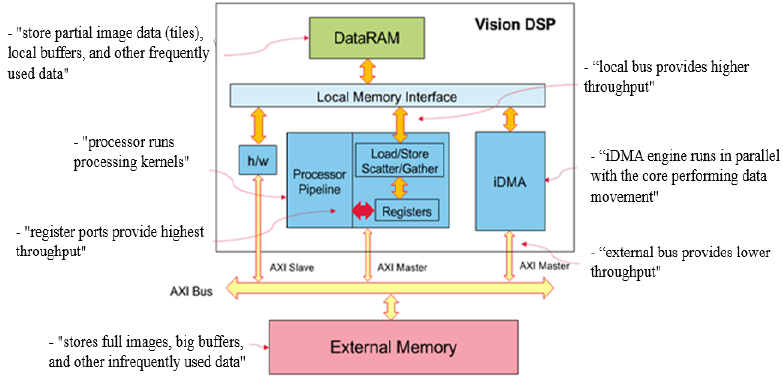
Figure 1. Vision digital signal processor (DSP) Block Diagram (the illustration is from Cadence Company technical material).